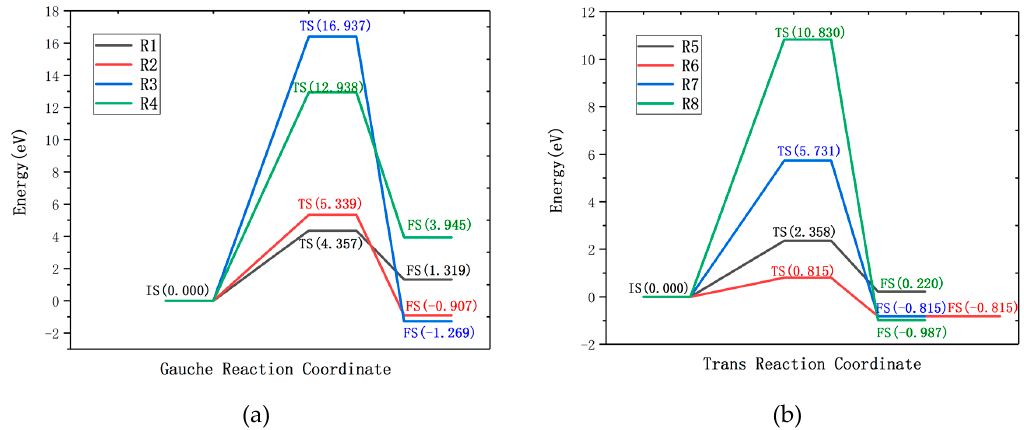
Figure 3. Reaction energy profiles of the R1–R4 reaction paths ( a ) and the R5–R8 reaction paths ( b ), Where the IS, TS and FS represent the initial state, transition state and final state, respectively.